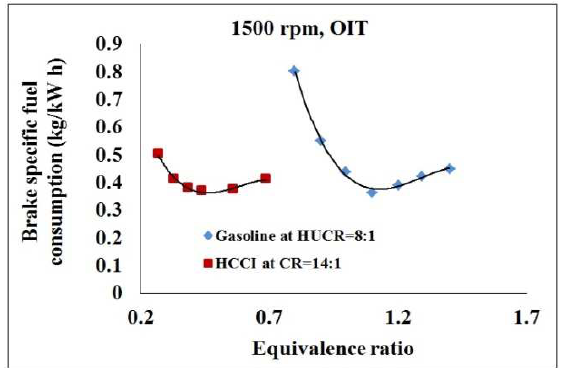
Fig. 5. bsfc of the two systems at HUCR for each one for wide range of equivalence ratio.